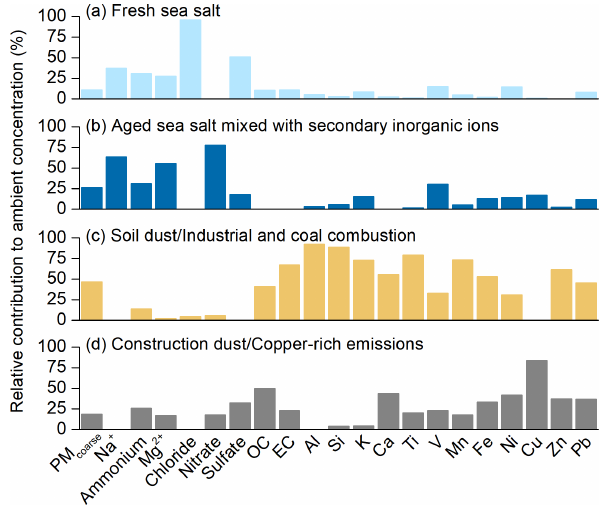
Figure 2. Factor profiles resolved by positive matrix factorization for source apportionment of PM coarse measured at Tuen Mun Air Quality Monitoring Station in Hong